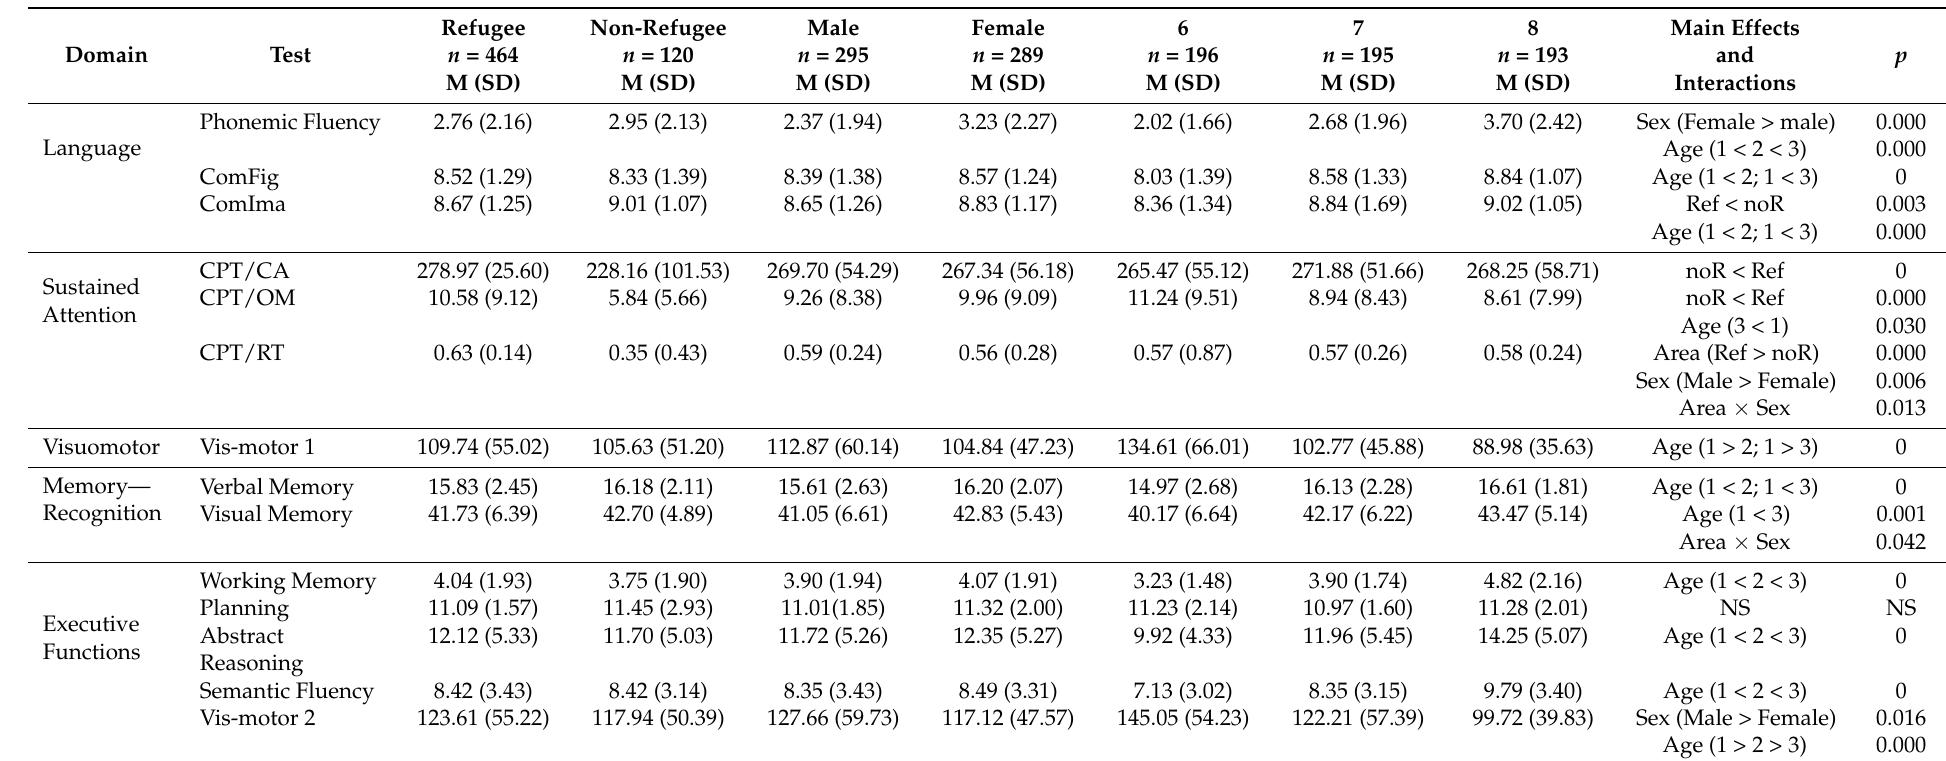
Table 3. Neuropsychological performance of Palestinian